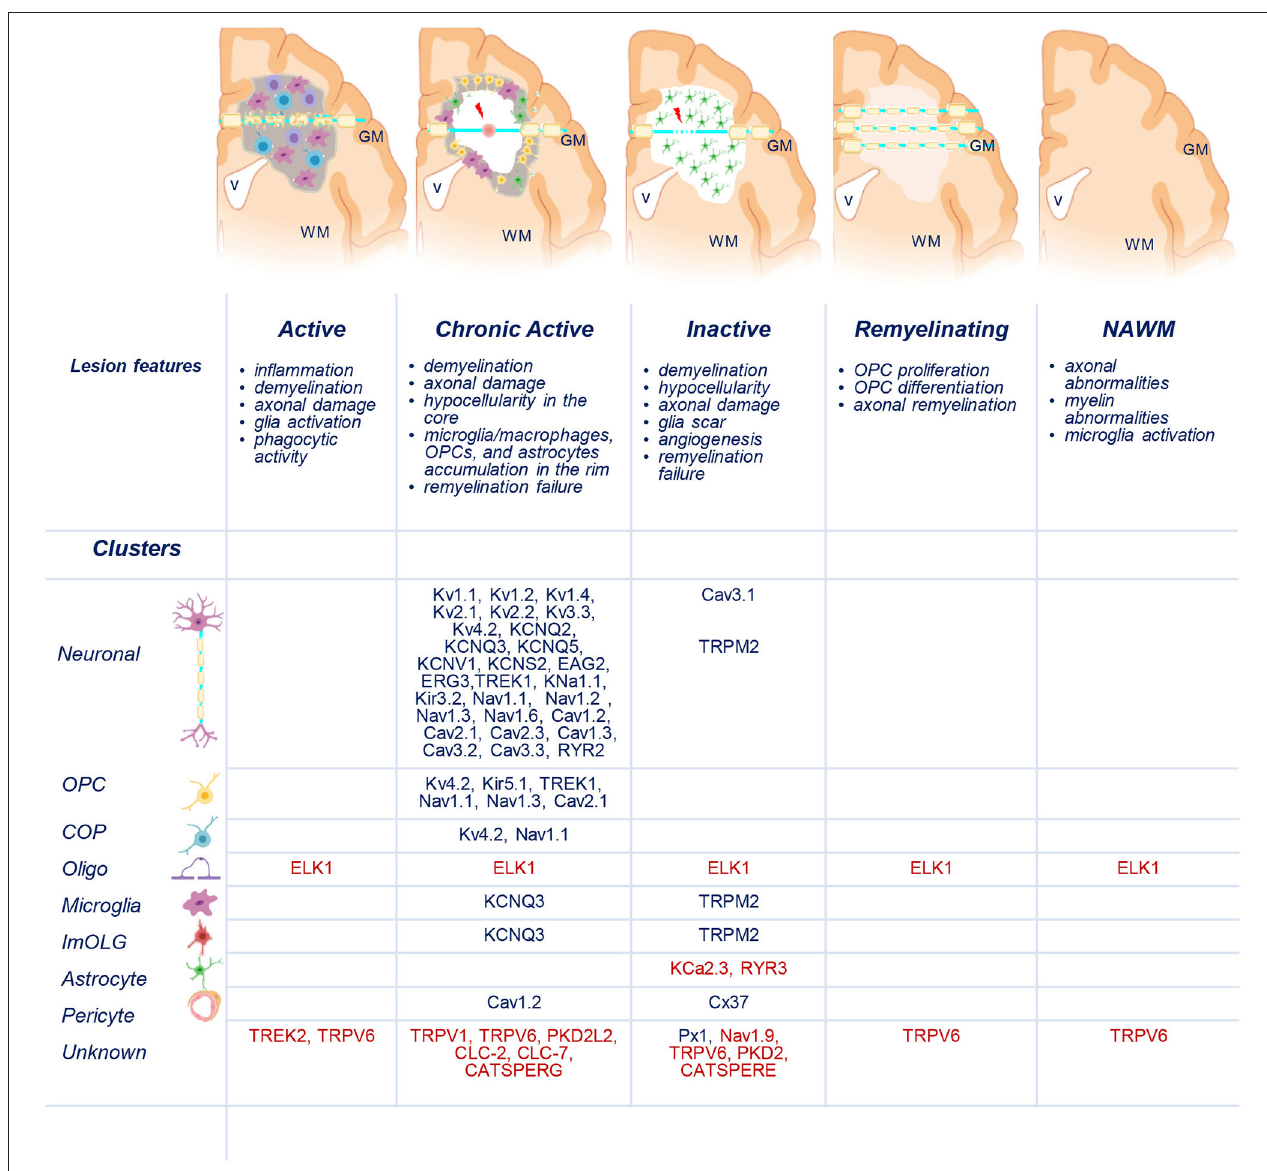
FIGURE 3 | Distribution of uniquely dysregulated genes encoding ion channels in SPMS lesions. Schematic representation of active (AL), chronic active (CA), inactive (IL), and remyelinating (RL) lesions, and normal-appearing white matter (NAWM). Upregulated (blue) and downregulated (red) ion channels encoded by uniquely dysregulated genes are listed according to their expression in the lesions and in neuronal, oligodendrocyte precursor cells (OPCs), committed OPCs (COPs), oligodendrocytes (Oligo), microglia, immune oligo (ImOLG), astrocyte, pericyte, and unknown clusters. GM, gray matter; WM, white matter; v, brain ventricle. Gray areas indicate active inflammatory lesion, white areas indicate demyelinated inactive lesions, red spot indicates tissue damage, red arrow indicates axonal dysfunction. Source icon is from